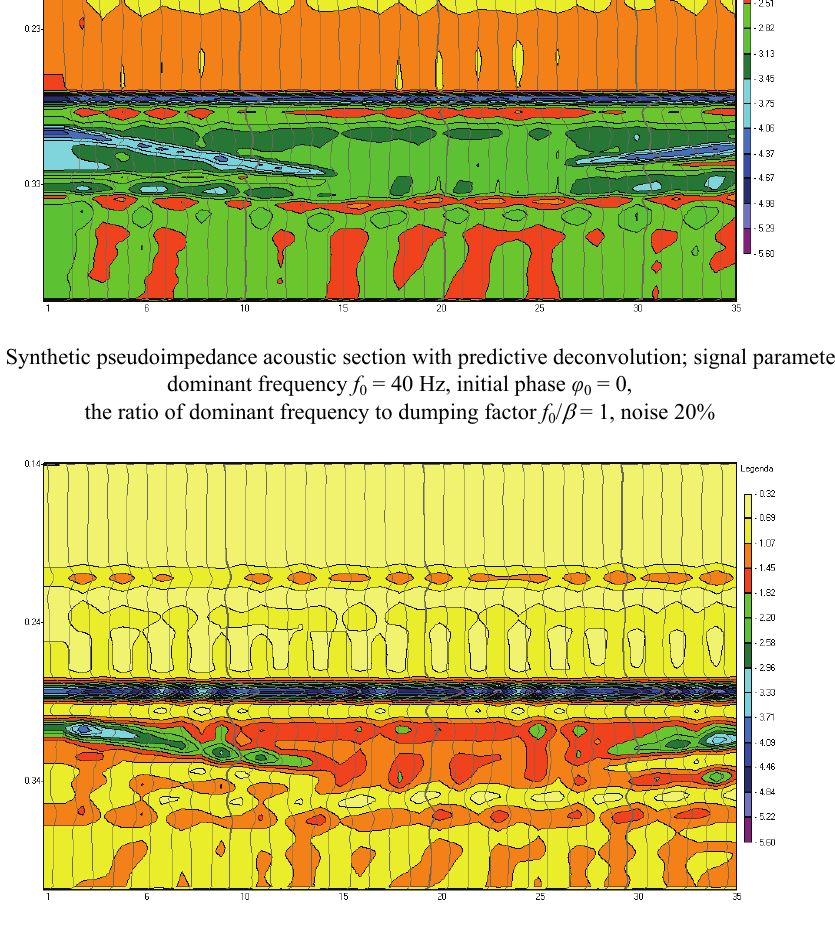
Fig. 5. Synthetic pseudoimpedance acoustic section with MED deconvolution; signal parameters: dominant frequency f 0 = 40 Hz, initial phase φ 0 = 0, the ratio of dominant frequency to dumping factor f 0 / β = 1, noise